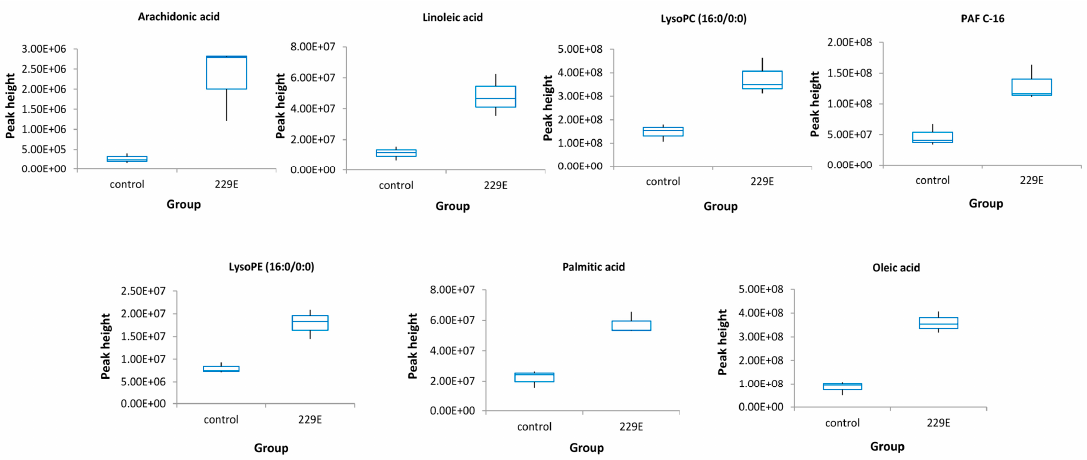
Figure 3. Box-whisker plots of the 7 standard confirmed lipids that were distinguished between the HCoV-229E-infected samples and the non-infected controls. The peak height was generated by LC-MS raw data. Control, non-infected cells; 229E, HCoV-229E-infected cells.